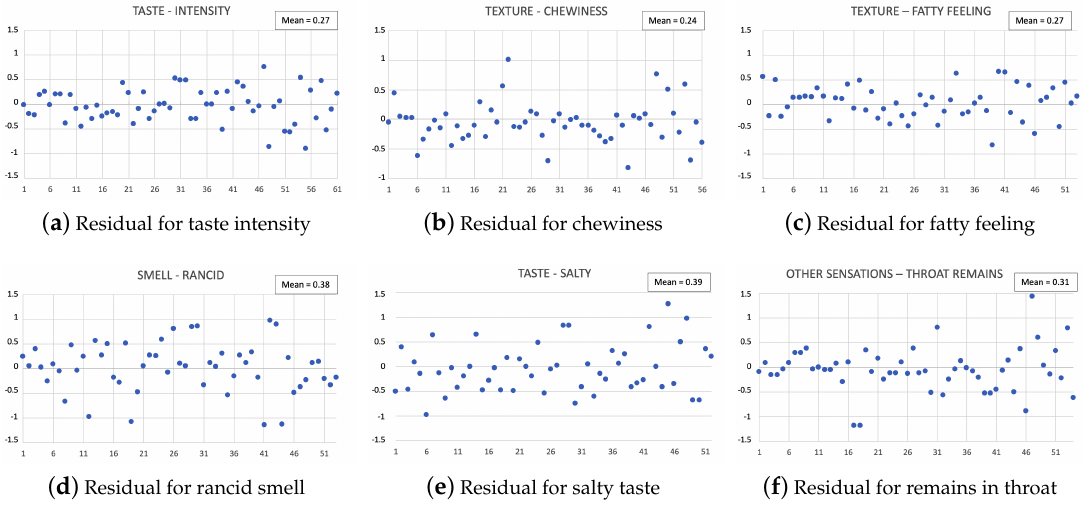
Figure 9. Residual for the predictions for different